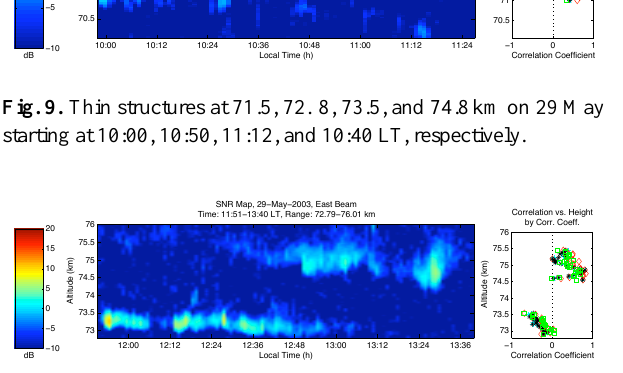
Fig. 14. A thin sheet at 64 km on July 14, 2004, at 13:15 LT.